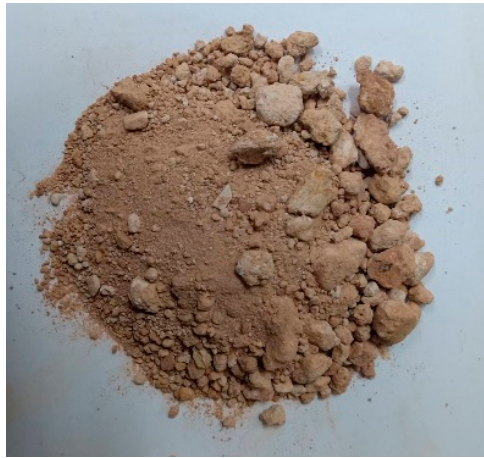
Figure 1. Lateritic soils. Table 1. General Requirements for standard subbase materials in tropical areas.